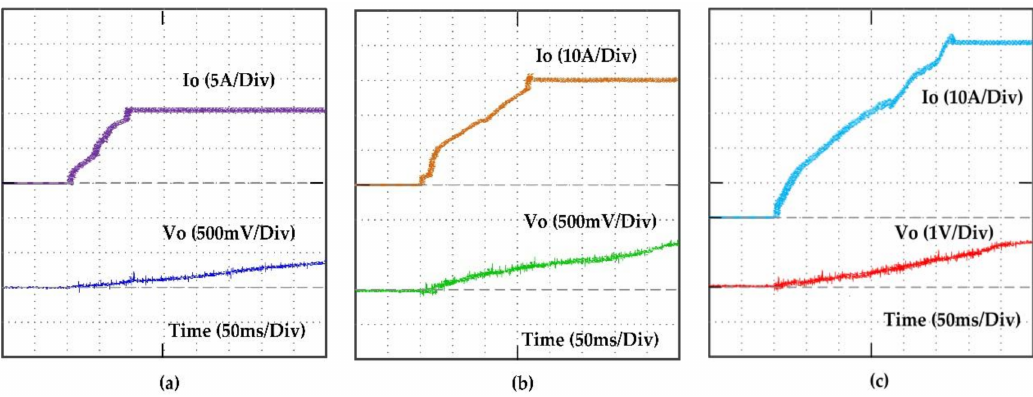
Figure 14. The supercapacitor bank (153 Wh) with zero initial charging voltage, connected to DAB-IBDC converter. The output voltage and current waveform during the soft-start period ( a ) 500 W, ( b ) 1.5 kW and ( c ) 2.5 kW.